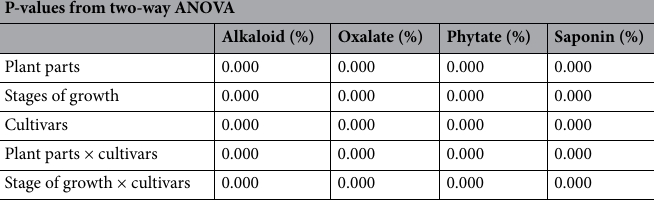
Table 8. ANOVA analysis of antinutrient composition of